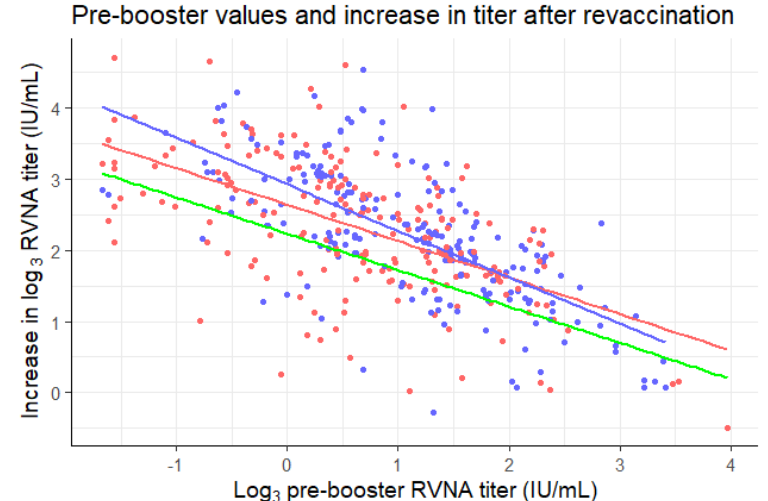
Figure 3. Pre-booster log 3 titers plotted against the differences in pre- and post-booster log 3 titers for the three-visit (red) and two-visit (blue) schedule. Linear regression lines were plotted for the data of each of the schedules in their corresponding color. Green line: three-visit schedule minus the non-inferiority margin of 0.369 (y = 2.6 − 0.51X − 0.369).